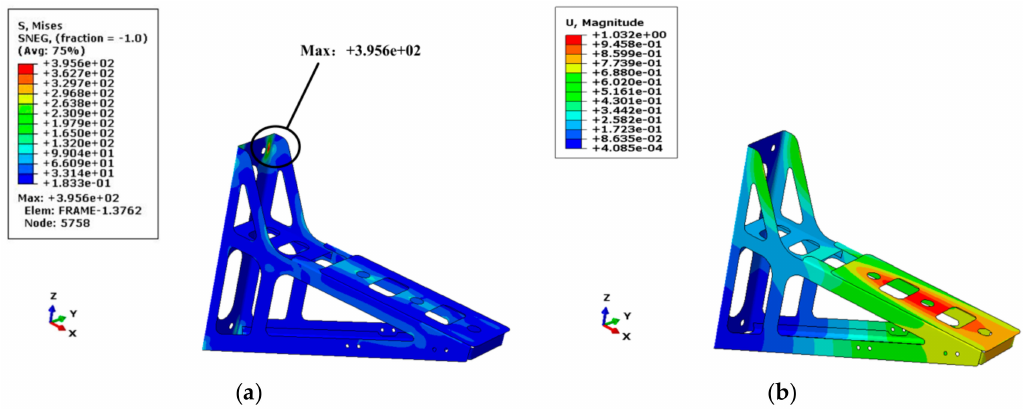
Figure 6. Von Mises stress nephogram ( a ) and ( b ) displacement nephogram of the final seat